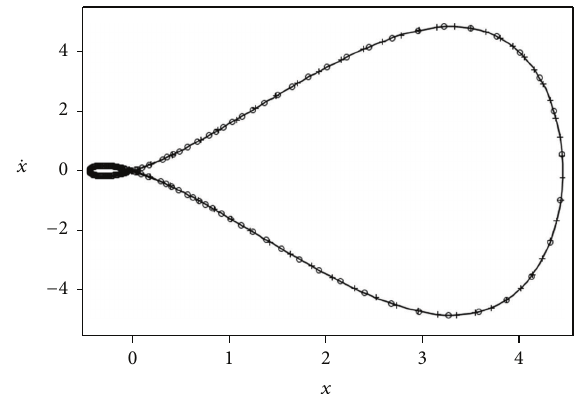
Figure 2: Phase portrait for homoclinic solutions 𝑥 of (23): — AUTO numerical method [30, 31]; I I I present method; + + + generalized harmonic function perturbation method